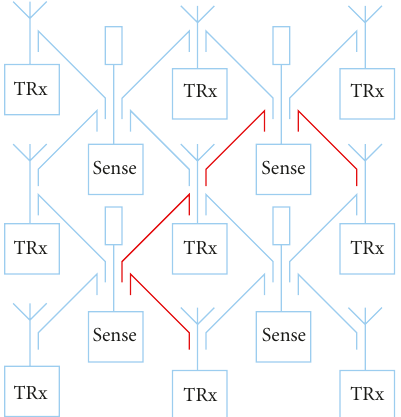
Figure 24: The redundant coupled calibration paths which may be useful in enhancing the quality of calibration.